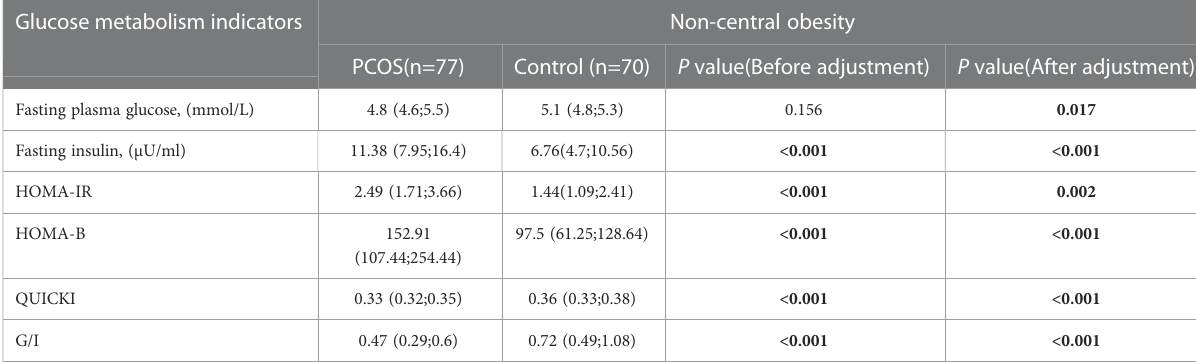
TABLE 3 Comparison of PCOS and Control glucose metabolism in non-central obesity after adjustment for body mass index and body fat percentage a . Glucose metabolism indicators